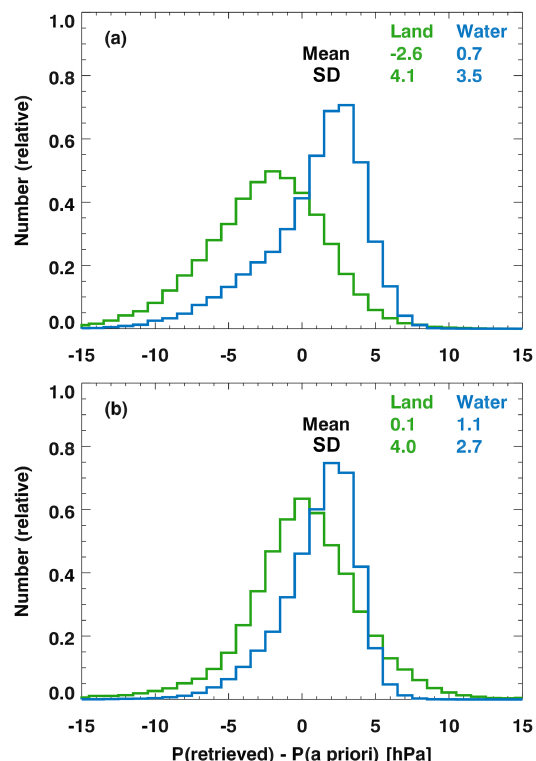
Figure 6. Retrieved minus prior surface pressure for a large selec- tion of OCO-2 soundings, using the oxygen-A band spectroscopy model from both (a) ABSCO v4.2 and (b) ABSCO v5.0, as de- scribed in the text. ABSCO v5.0 spectroscopy leads to a more con- sistent retrieval of surface pressure over both land and ocean sur-